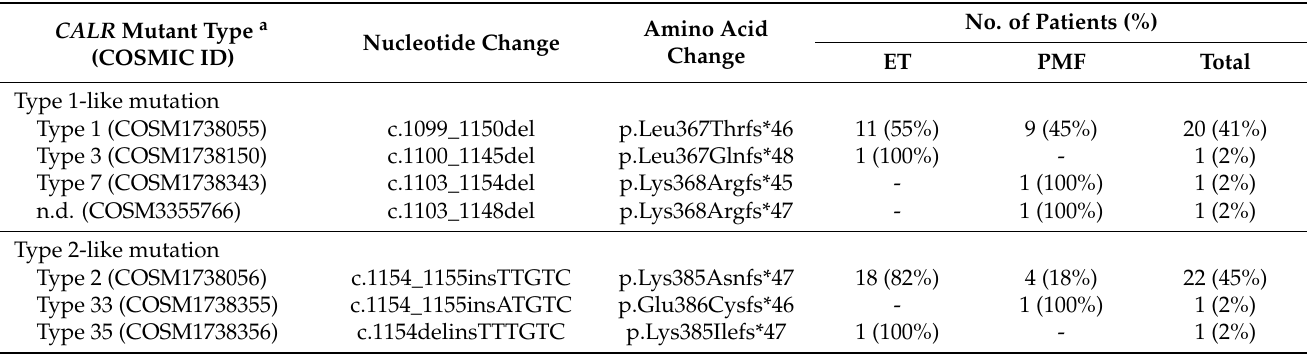
Table 2. Identified CALR mutations and their mutant